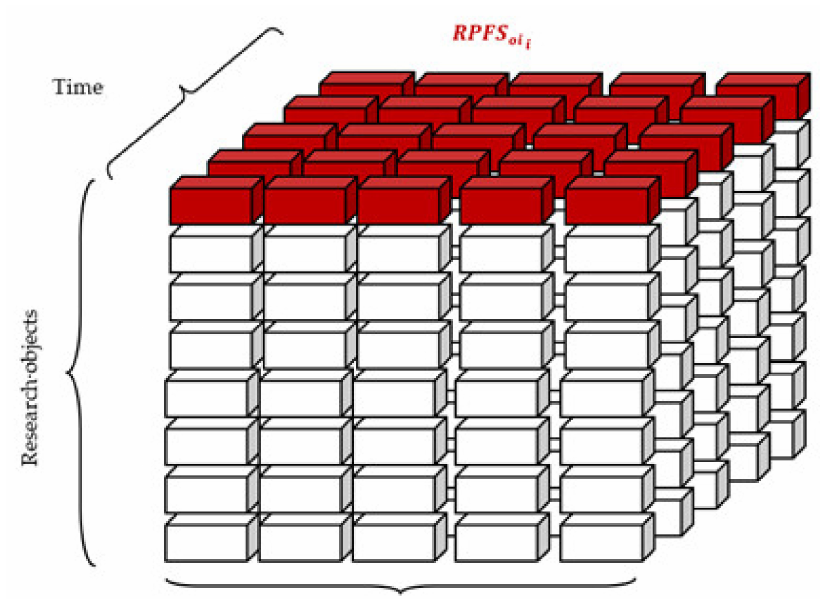
Figure 5. The condition space based on protocol and related